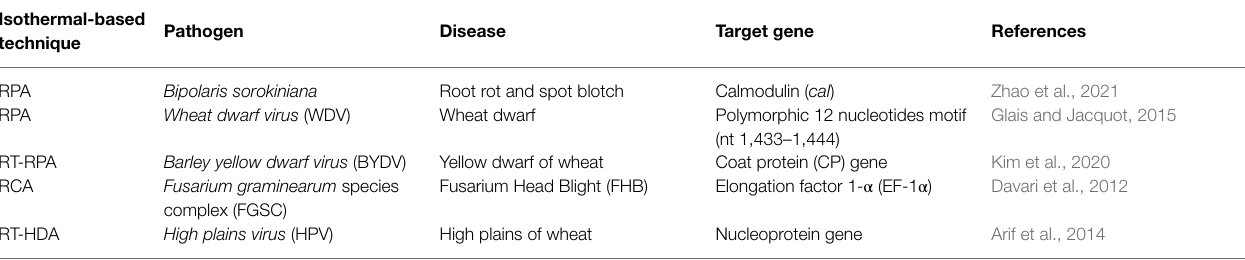
TABLE 2 | Isothermal-based detection of various pathogens in wheat. Isothermal-based technique